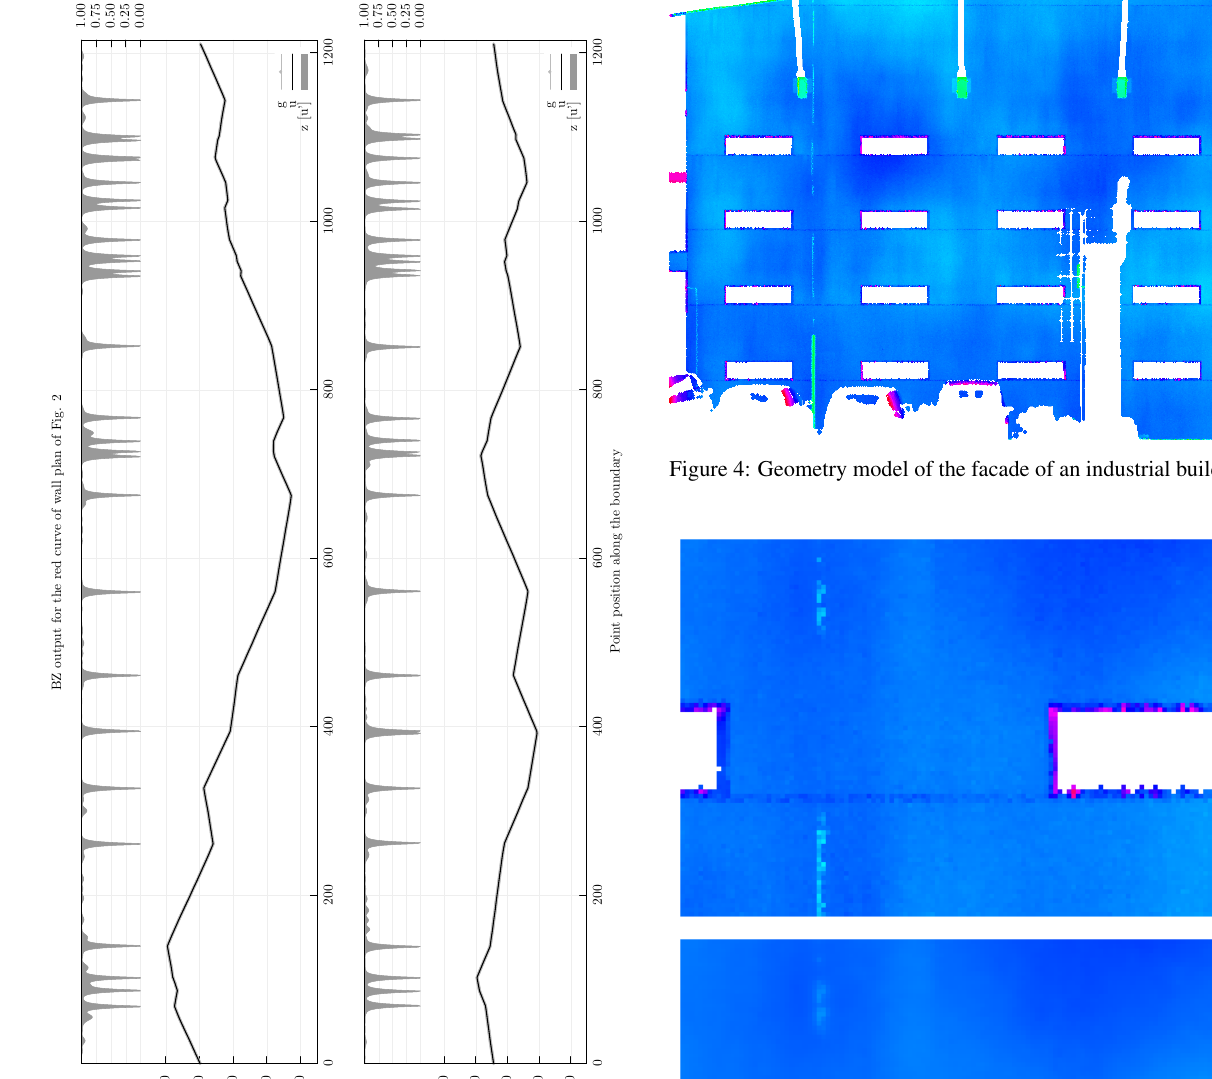
with a dead vertex. Those lines describes discontinuities of the function u that gently disappear and that can not be identified as boundaries. This fact is deeply related to the characteristics of the Mumford-Shah model that, right for this reason, is also known as a model for the detection of free discontinuity rather than of free boundaries. The word free refers to the fact that the set K is one of the unknowns involved in the model (De Giorgi, 1991; Am- brosio et al., 2000). Figure (11) shows in color the polygonal shapes identified using the Blake-Zisserman auxiliary function z obtained by the processing of the boundaries of the